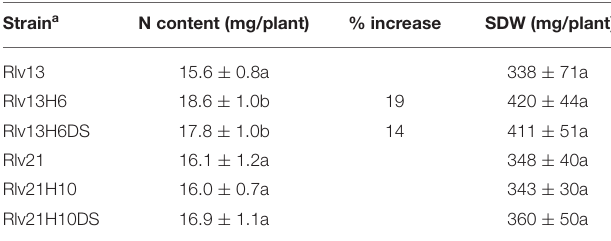
Values are the mean of 4 replicates ± S.E. Values followed by a different letter indicate significant differences with the corresponding wild-type strain according to Fisher’s L.S.D